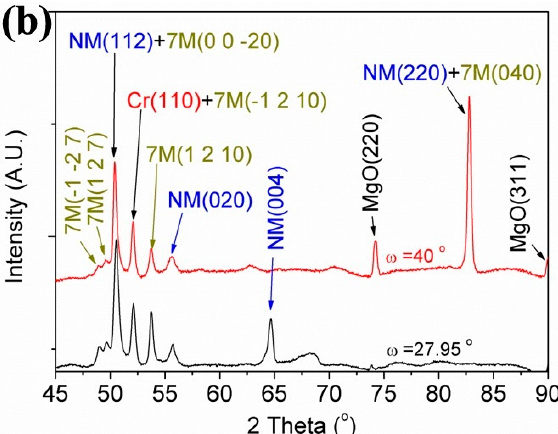
Figure 10. XRD patterns of as-deposited Ni 50 Mn 30 Ga 20 thin films: ( a ) conventional θ –2 θ coupled scanning at different tilt angles ψ ; and ( b ) 2 θ scanning at two incident angles ω and integrated over the rotation angle ϕ .